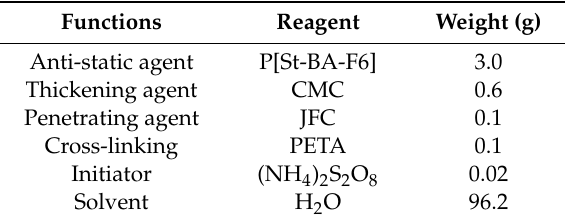
Figure 2. Flowchart of printing process on the pretreated and the crossing reaction of Polyethylene terephthalate (PET) fabric. Table 1. A typical recipe for solutions for pretreatment of PET fabric.